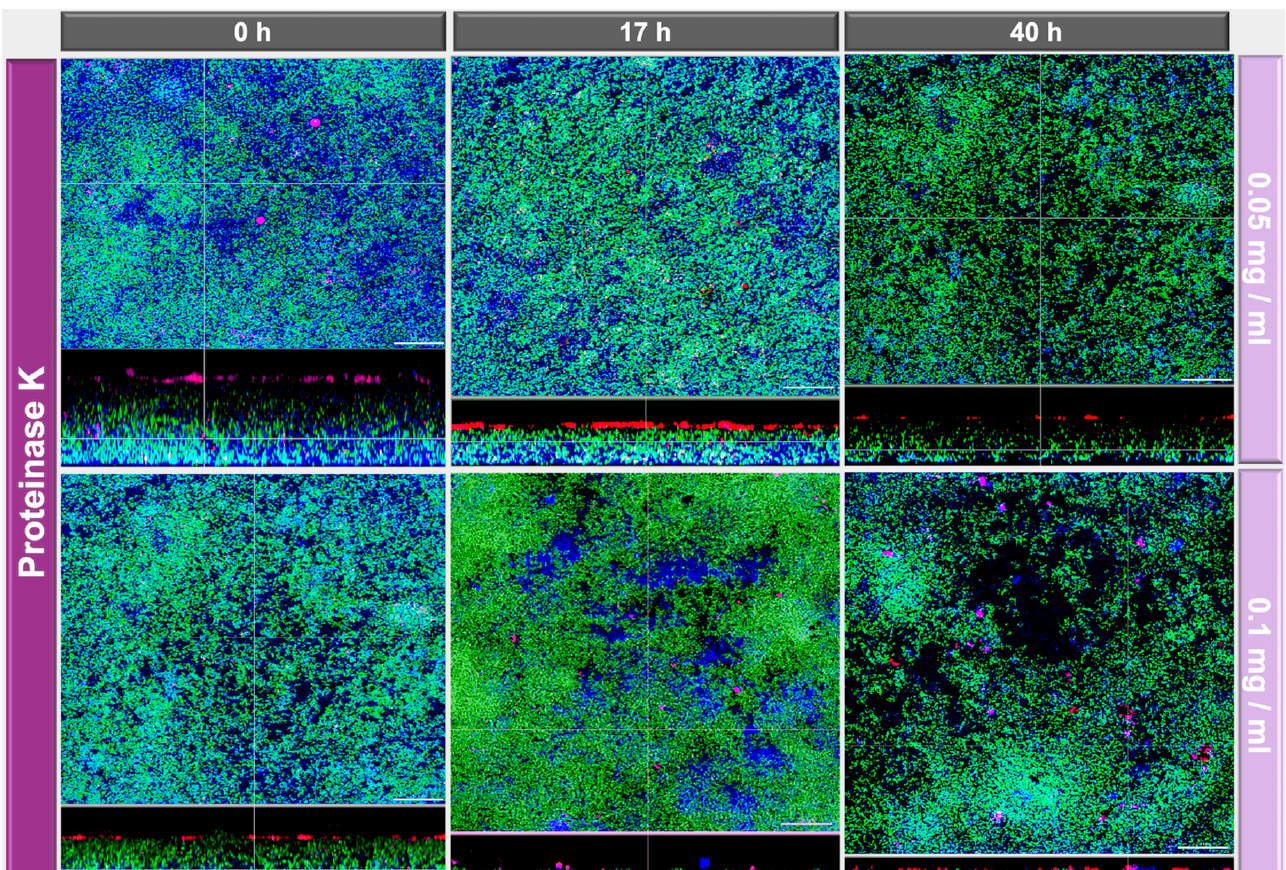
Figure 4. CLSM images show the multispecies biofilms after proteinase K exposure are two concentrations (0.05 mg/mL, 0.1 mg/mL) and intervals (0 h, 17 h, 40 h). Bacteria are stained green (Yo Pro 1/Sytox Green DNA-staining), extracellular polymeric substances (EPS) blue (calcofluor), extracellular DNA appear red (anti-DNA antibodies and streptavidin, Cy3), and extracellular proteins magenta (SYPRO Ruby). The cross section shows the base of the biofilm base, which is directed towards the top view with a scale of 20 μ m.